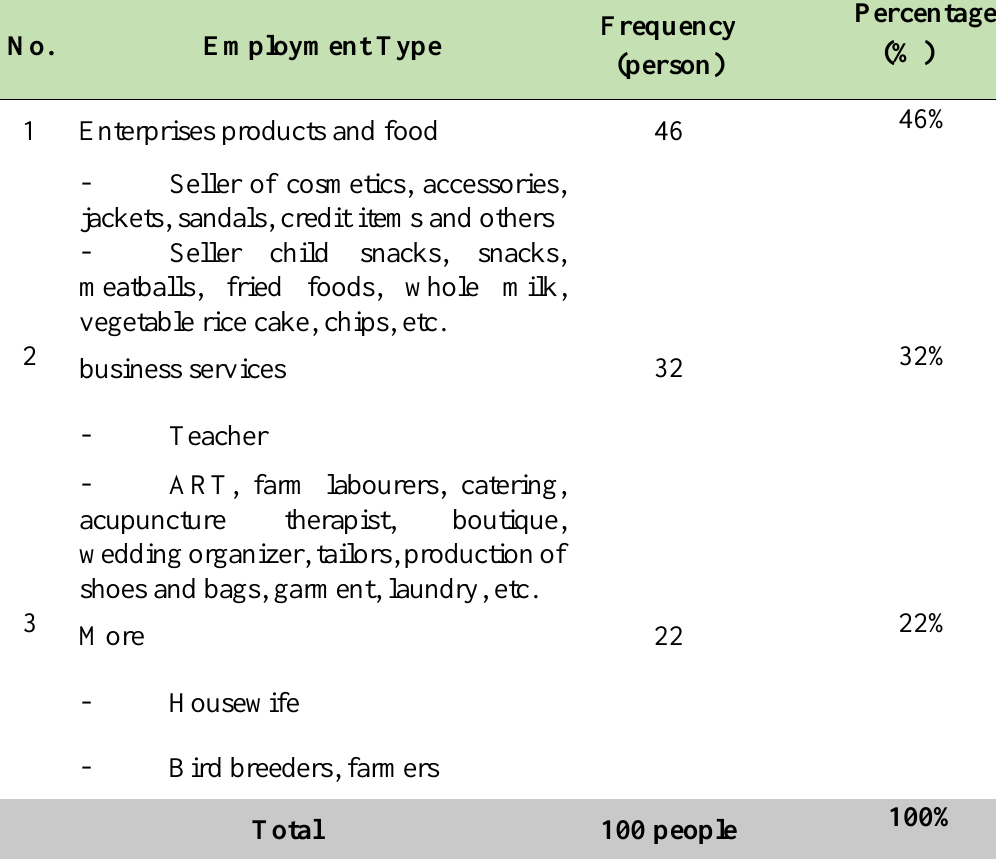
Table 3 Respondents based on Types of Employment